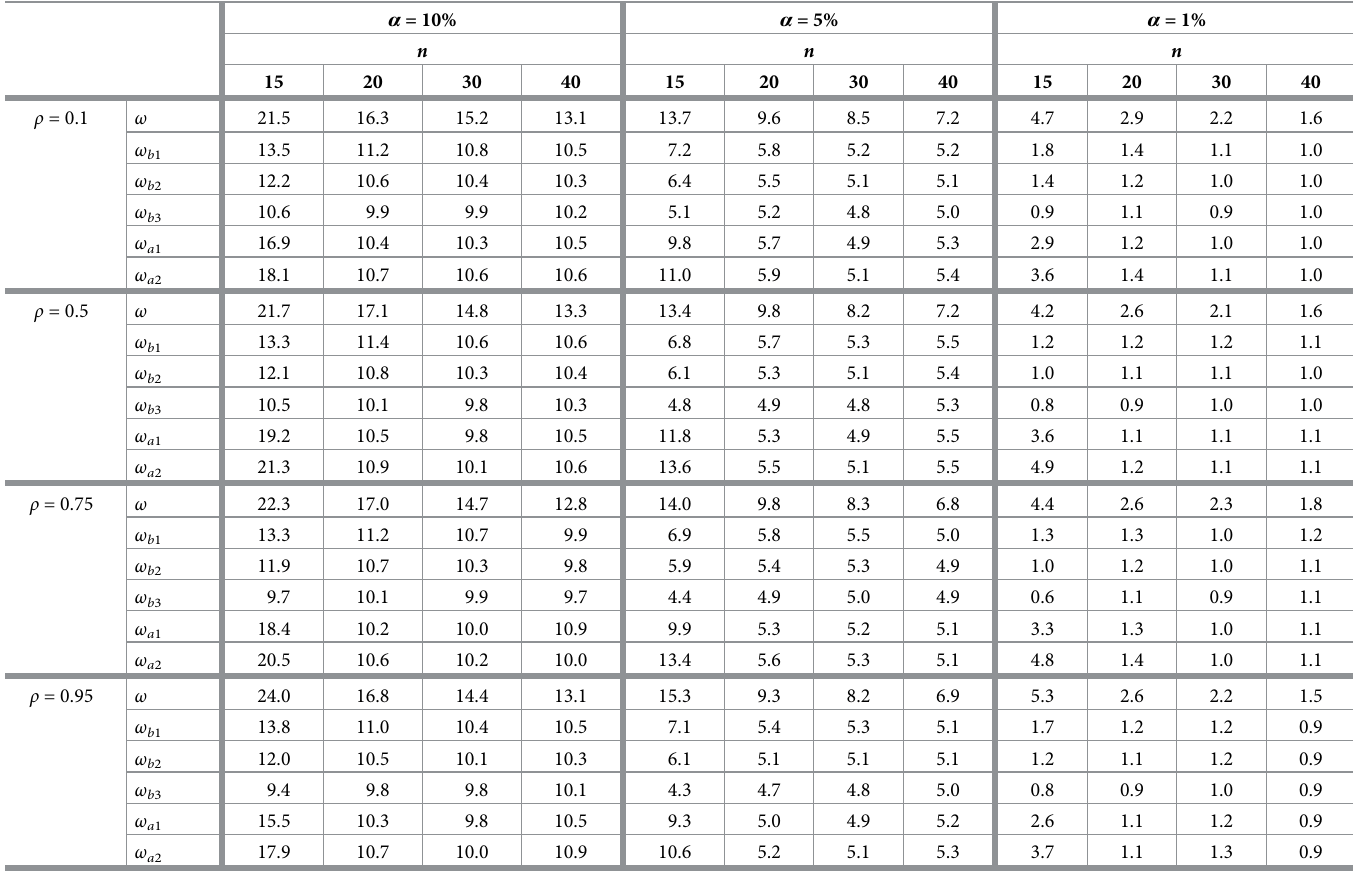
: b ¼ b ¼ 0 ( l = 2); varying correlation between 0 2 3